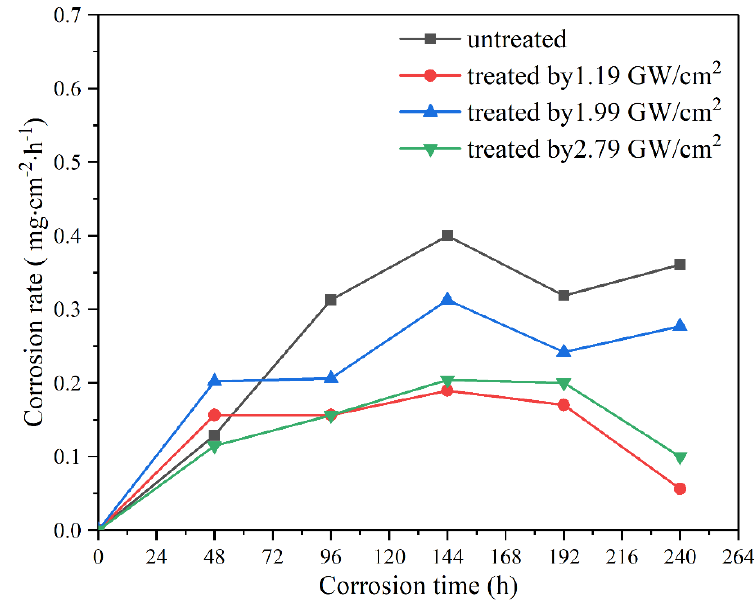
Figure 7. Corrosion rate diagram of four samples immersed in SBF within 10 days.